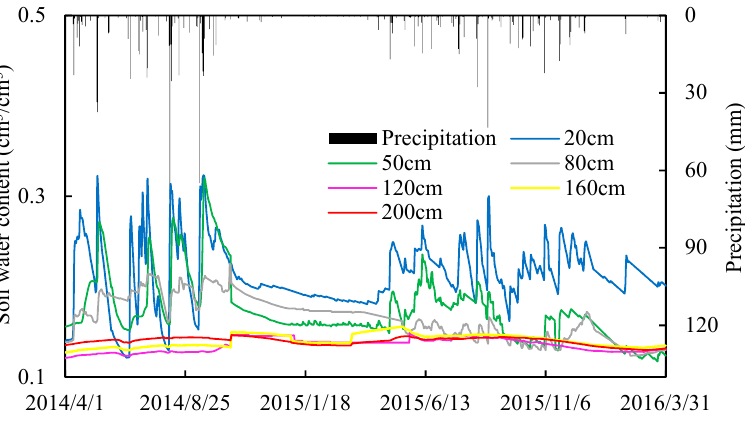
Figure 3. Temporal variations in the soil water dynamics at typical soil depths.